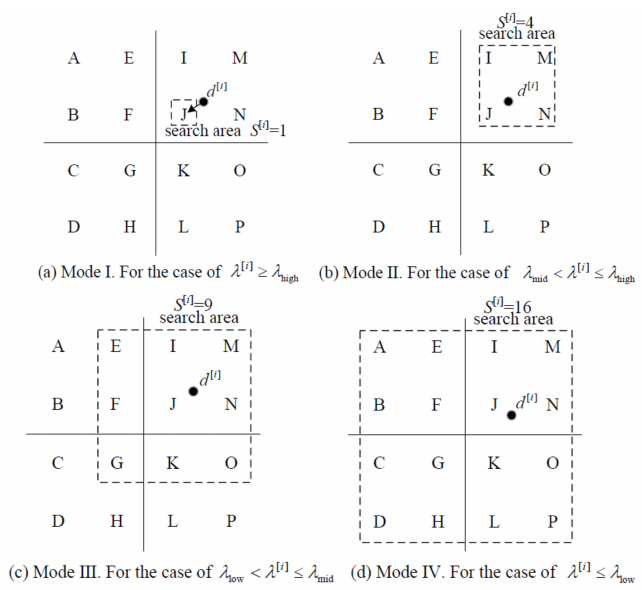
Figure 4. Example of four - Mode adaptation of the proposed